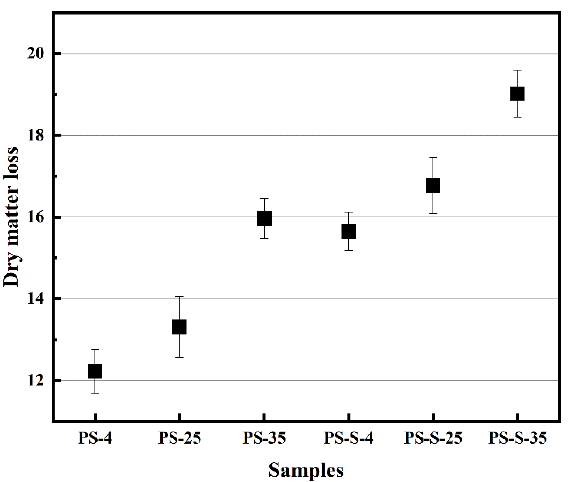
Figure 2. Dry matter loss of the PS after storage under anoxic atmosphere.